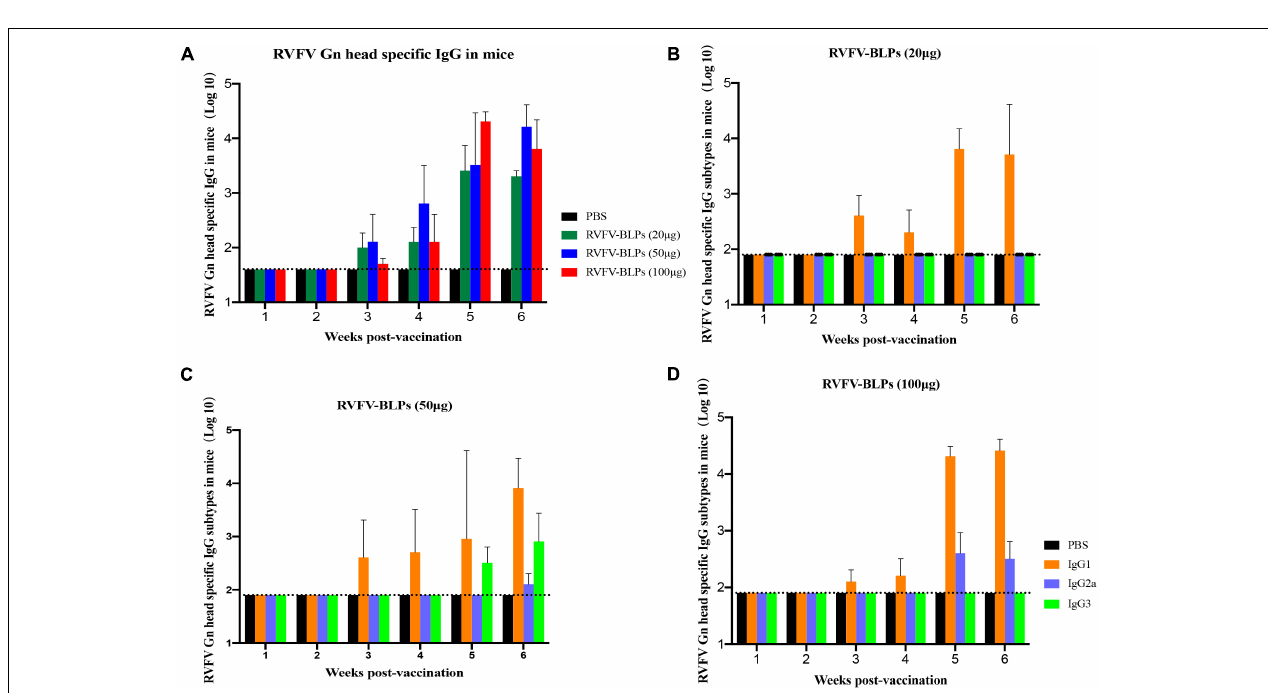
FIGURE 6 | Detection of antibody levels in immunized mice sera. Sera collection from mice immunized with different amounts of RVFV-BLPs. RVFV Gn head-specific IgG ( p > 0.05), IgG1, IgG2a, and IgG3 levels in the serum were assessed by indirect ELISA; data are shown as the means ± SD. RVFV Gn head-specific IgG levels in mice immunized with different amounts of RVFV-BLPs (A) , and the levels of IgG subtypes in RVFV-BLPs (20 µ g) (B) , RVFV-BLPs (50 µ g) (C) and RVFV-BLPs (100 µ g) (D) . Dotted line is cutoff values, calculated as OD450 of control × 2.1. Data are shown as the mean ± SEM and were analyzed by an unpaired t -test.